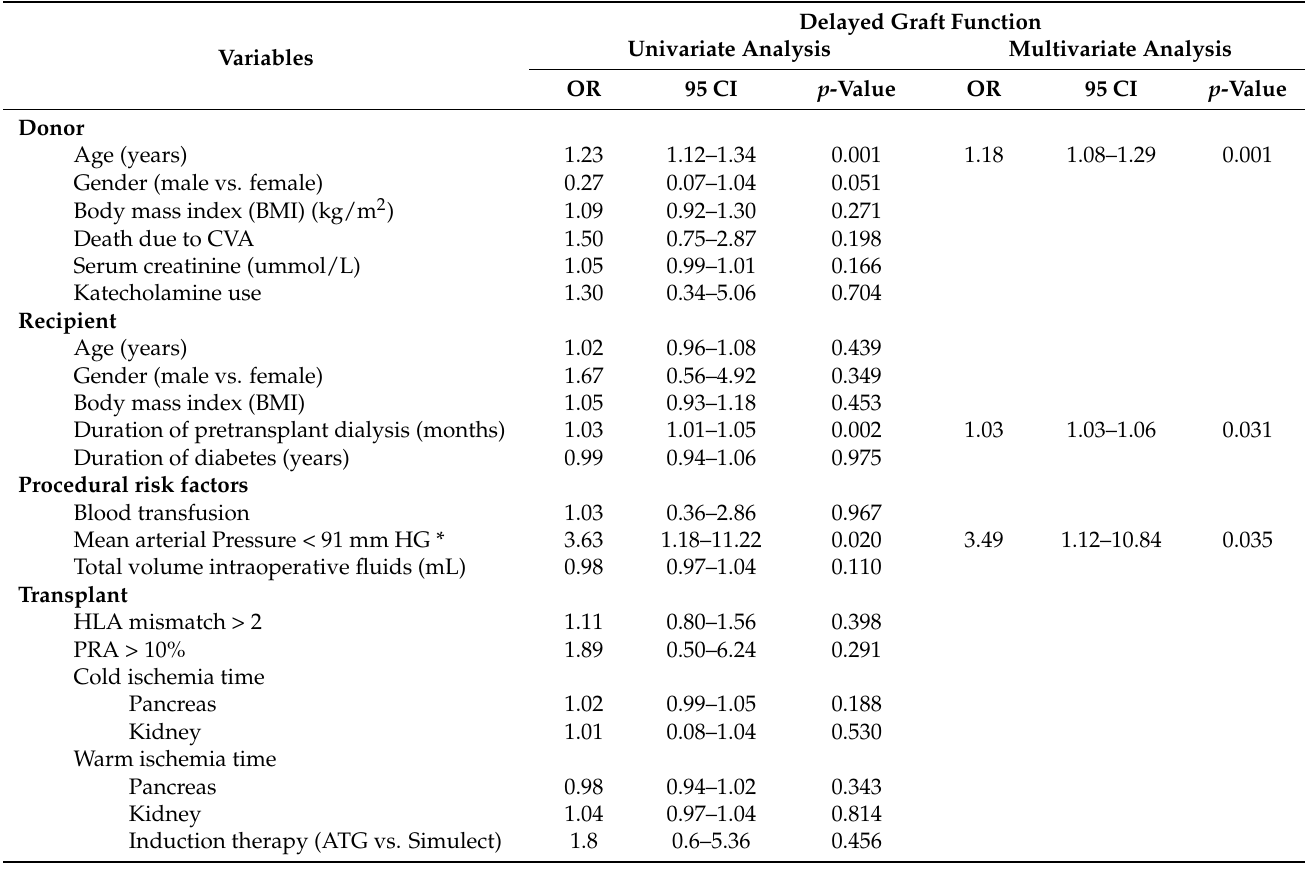
Table 6. Multivariate logistic regression analysis of predictors for delayed kidney graft function after simultaneous pancreas–kidney